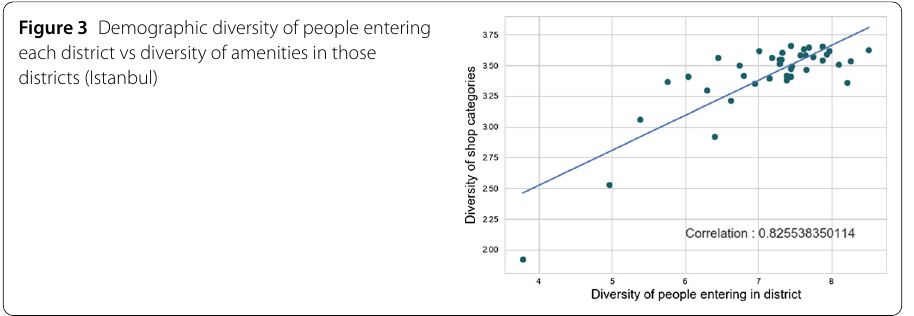
Figure 3 Demographic diversity of people entering each district vs diversity of amenities in those districts